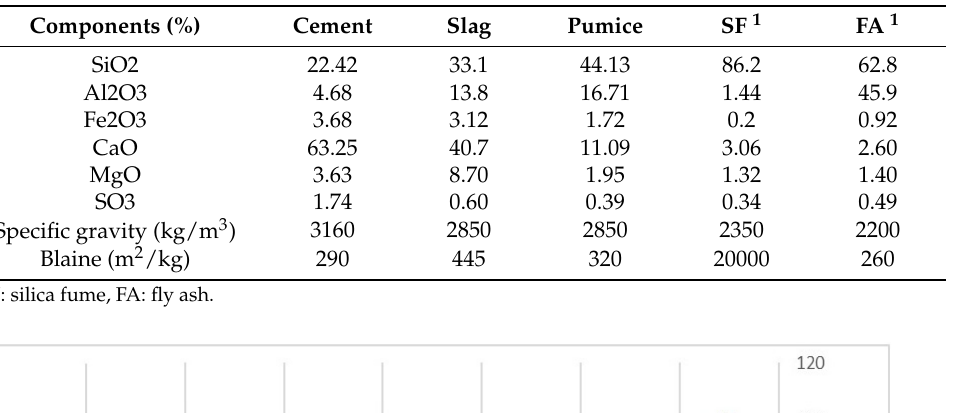
Table 1. Chemical ingredients of binder aggregates [40].